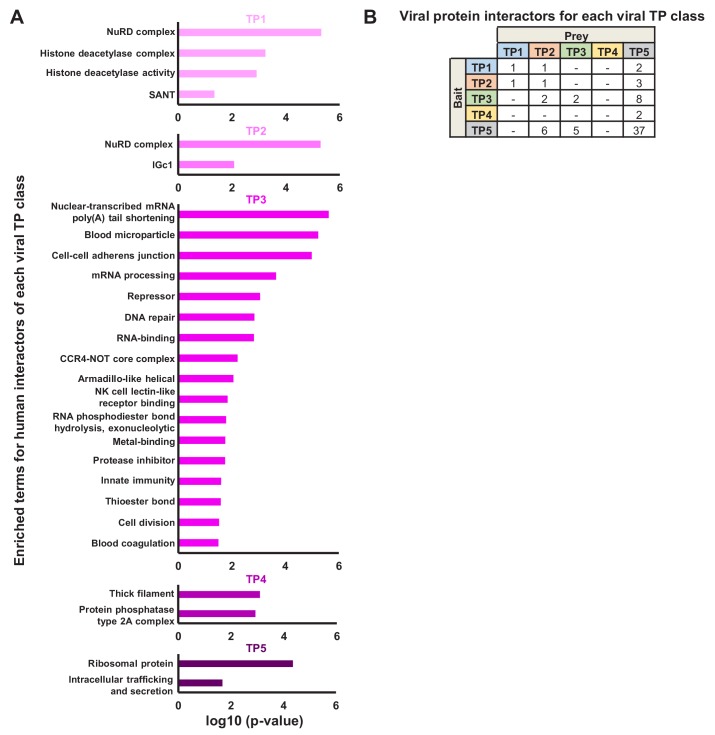
Further details of interactions according to viral protein temporal class.(A) Functional enrichment of host HCIPs for each temporal class of viral bait. DAVID software with default settings (Huang et al., 2009) was applied to determine which pathways were enriched amongst human HCIPs of each of the Tp1-Tp5 classes of bait, in comparison to all human HCIP as background. Benjamini-Hochberg adjusted p-values are shown on the x-axis. (B) Temporal analysis of viral-viral protein interactions. The contingency table shows 71 viral protein-protein interactions for which both bait and prey had a defined Tp class (from Weekes et al., 2014).